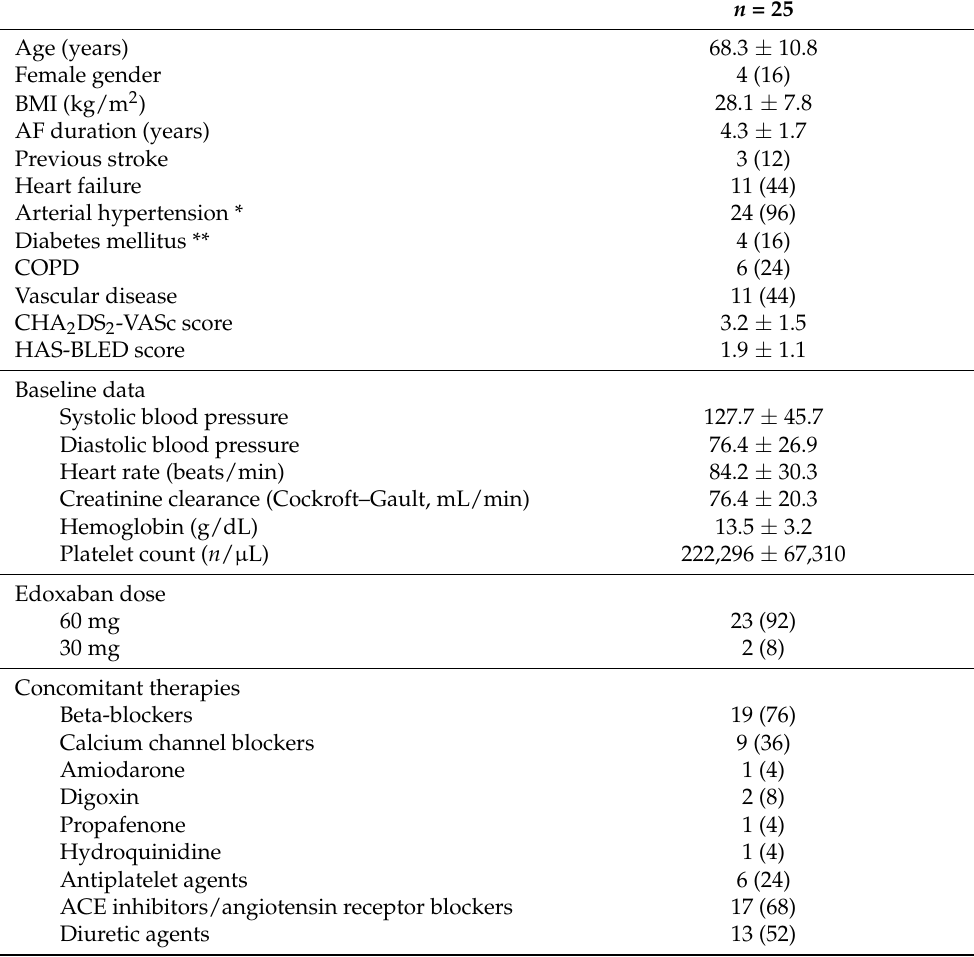
Table 1. Main demographic/clinical features of the study